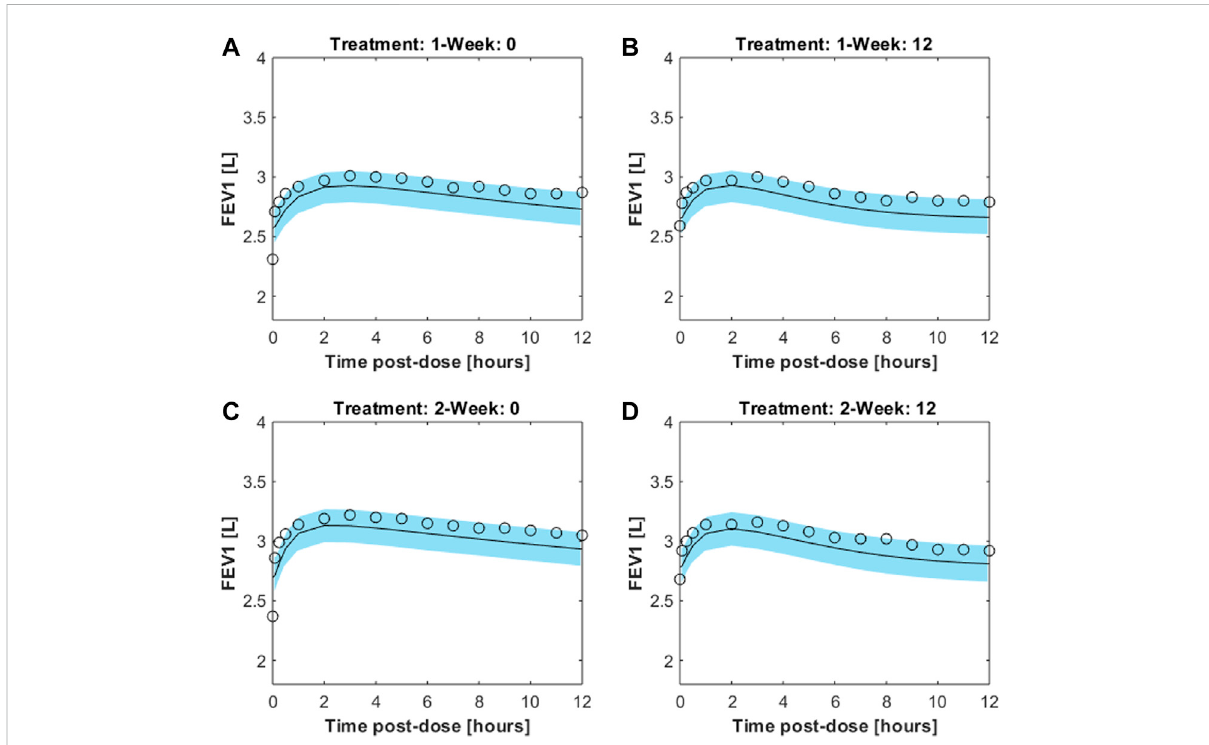
FIGURE 5 Results from 200sets of 100simulated individuals, each. For each simulated individual, trend over time of FEV 1 was simulated by running the model with parameters set to the fi xed and estimated values from the second fi tting procedure, except for the speci fi c individual parameters age, height, gender and percentage of restriction. Continuous black lines are the mean trends over time from the 200sets whereas light-blue areas represent the 95% con fi dence bands of means (between its 2.5% and 97.5% percentiles). Results are showed for the two experimental regimes both at week 0 and at week 12 for double-blind treatment with formoterol 12g [panels (A,B) , respectively] and with formoterol 24g [panels (C,D) , respectively].TheimageusedinFigures5and6havepartlabelsAD;however,thedescriptionismissinginthecaption.Couldyouclarifythis?Provide revised fi les if